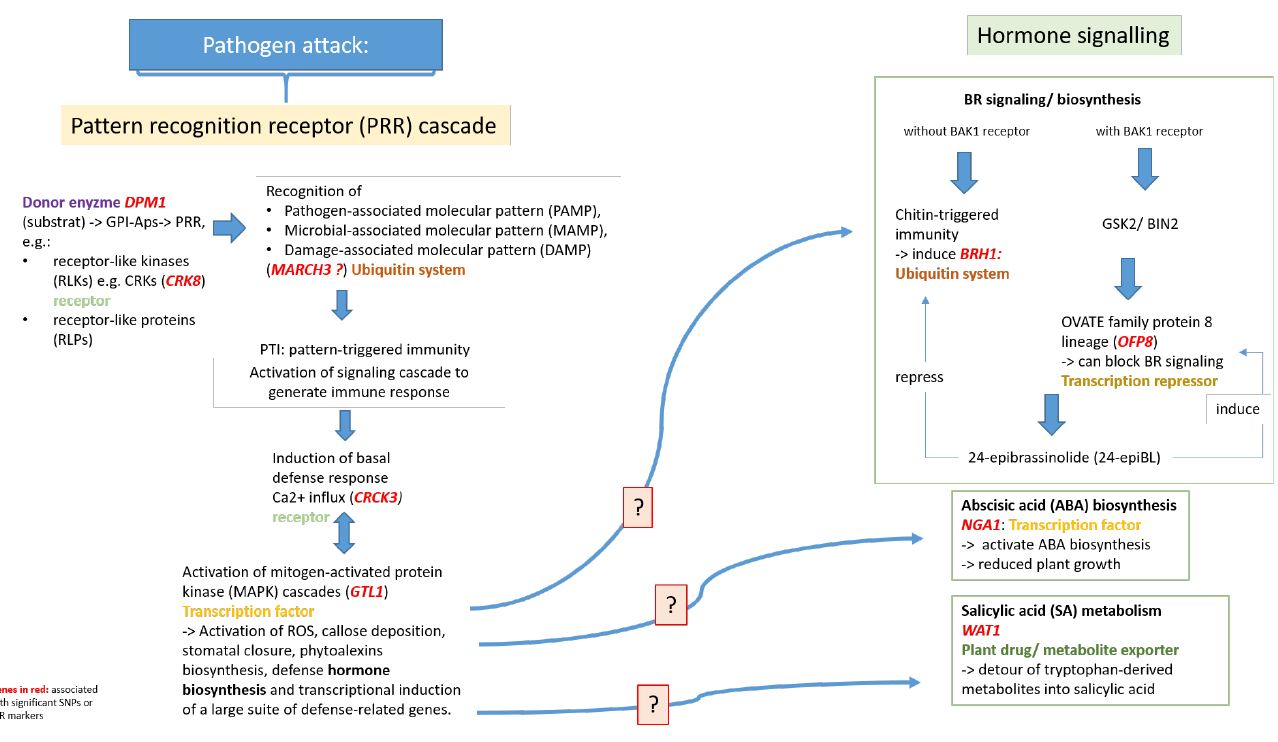
Figure 2. Candidate genes involved in the signal transduction pathway of plant innate immunity or subsequent hormone signaling in response to ARD. Candidate genes associated with significant SNP or SSR markers are highlighted in red. C RK3 : calmodulin-binding receptor-like cytoplasmic kinase 3 , NGA1: B3 domain-containing protein Os03g0120900-like , MARCH3: E3 ubiquitin-protein ligase MARCH3 , DPM1: dolichol-phosphate mannosyltransferase , WAT1: walls are thin1-related protein , GTL1: trihelix transcription factor , OFP8: OVATE family protein 8-line , CRK8: cysteine-rich RLK (RECEPTOR-like protein kinase) 8 , BRH1: E3 ubiquitin-protein ligase RHA2B-like .